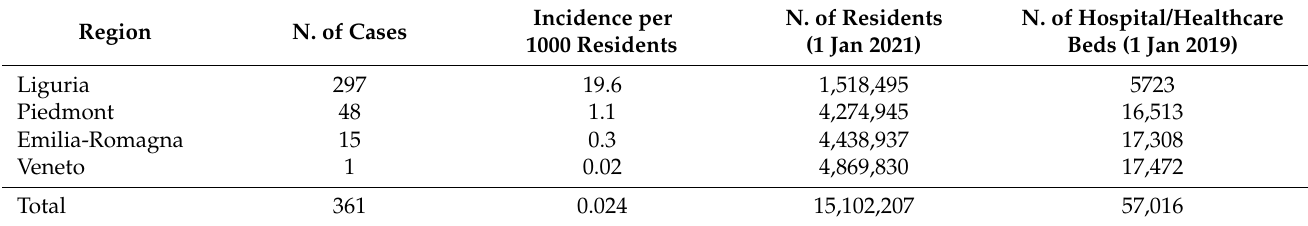
Table 2. Incidence rate of C. auris cases per 1000 residents and number of healthcare beds by region, Liguria, Piedmont, Emilia-Romagna and Veneto regions, Italy, July 2019–December 2022. Incidence per 1000 Region N. of Cases Residents